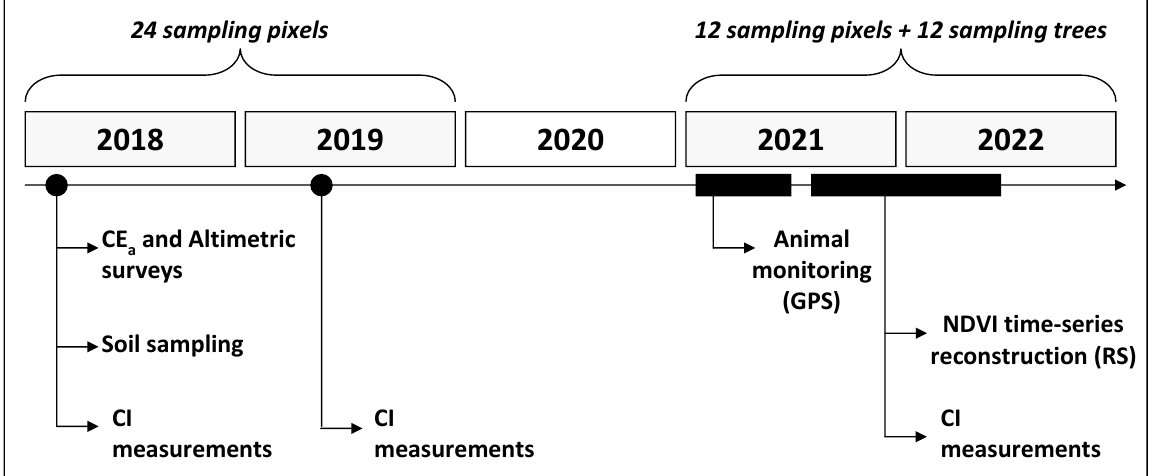
Figure 2. Timeline of measurements carried out in the experimental field.